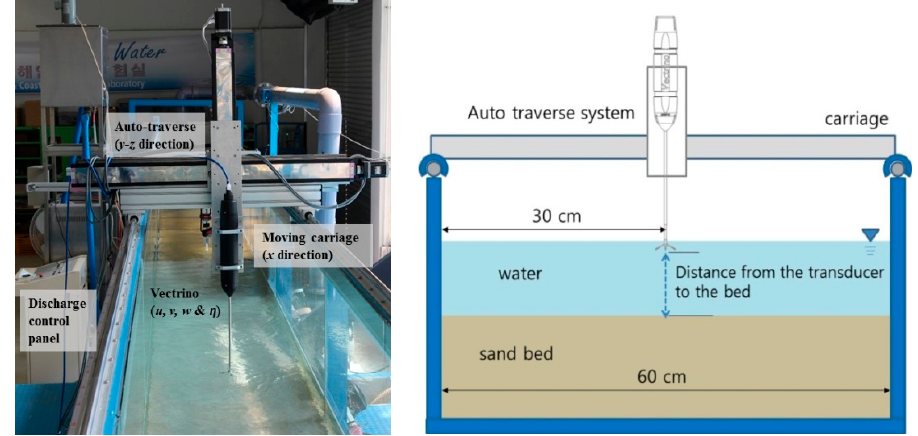
Figure 3. Schematic diagram of experimental channel and apparatus (side view).